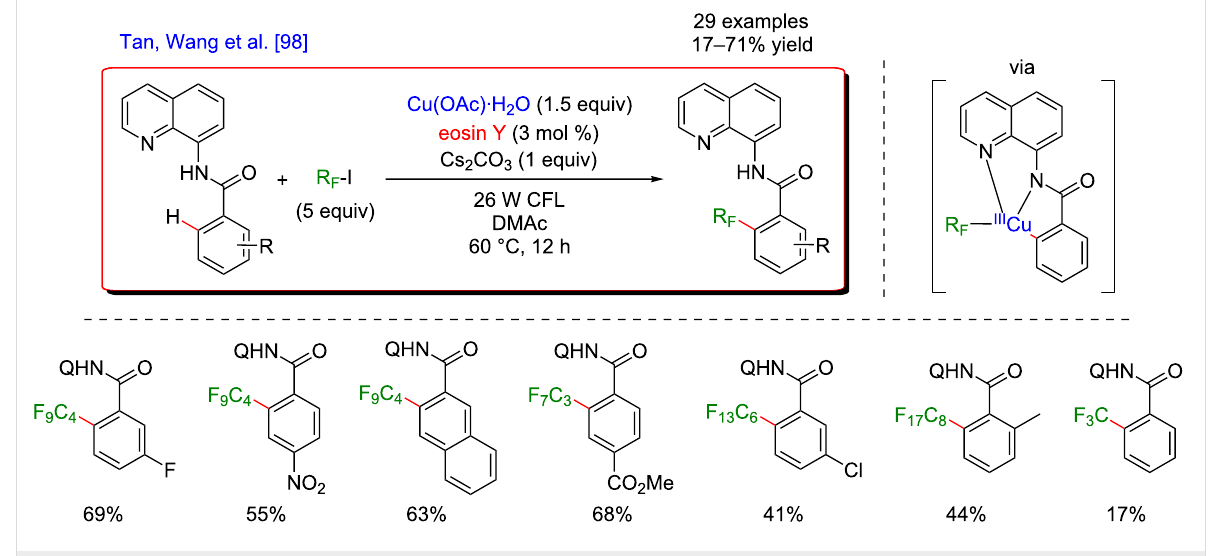
Figure 33: Perfluoroalkylation of arenes via the dual C–H activation/photoredox catalysis.